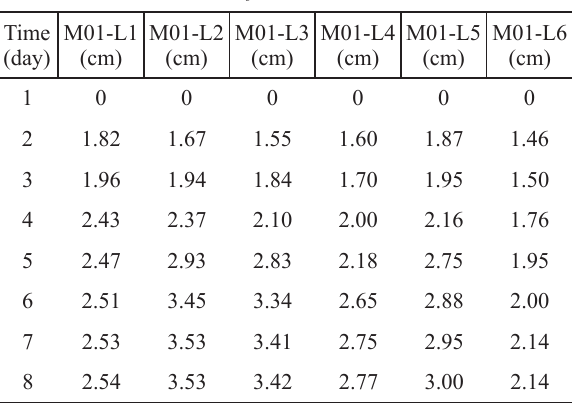
Table 1 – Measurement of discoloration circle diameter Time M01-L1 (day) (cm)